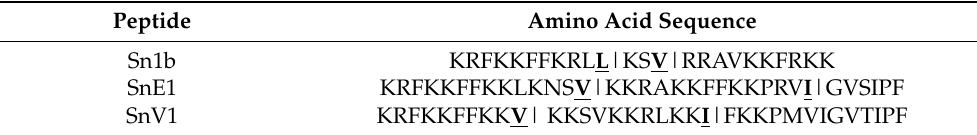
Table 3. Peptide neutrophil elastase cleavage sites, indicated by amino acid in bold and underline, as determined by mass spectrometry profiles of NE-incubated peptides. Peptides are cleaved after each cleavage site